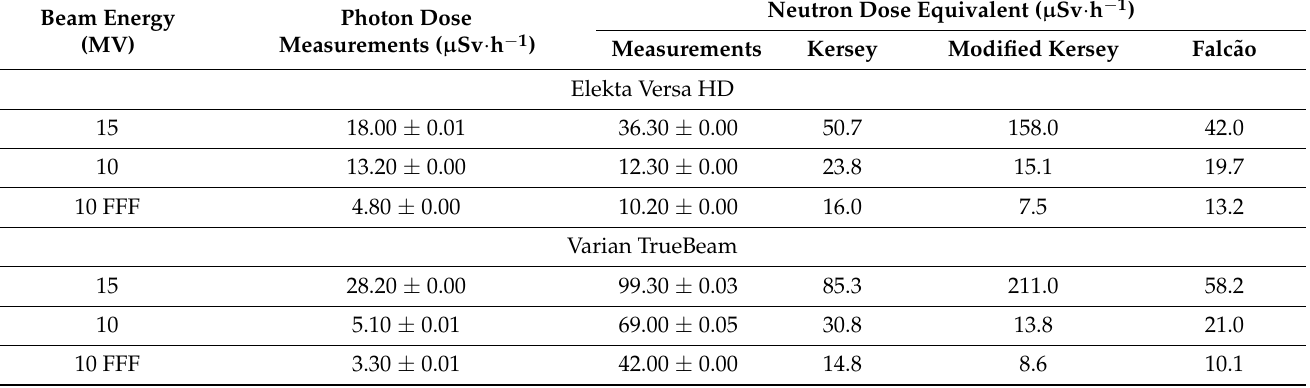
Table 3. Neutron and gamma dose equivalent at 0.3 m from the entrance of the maze ( µ Sv · h − 1 )